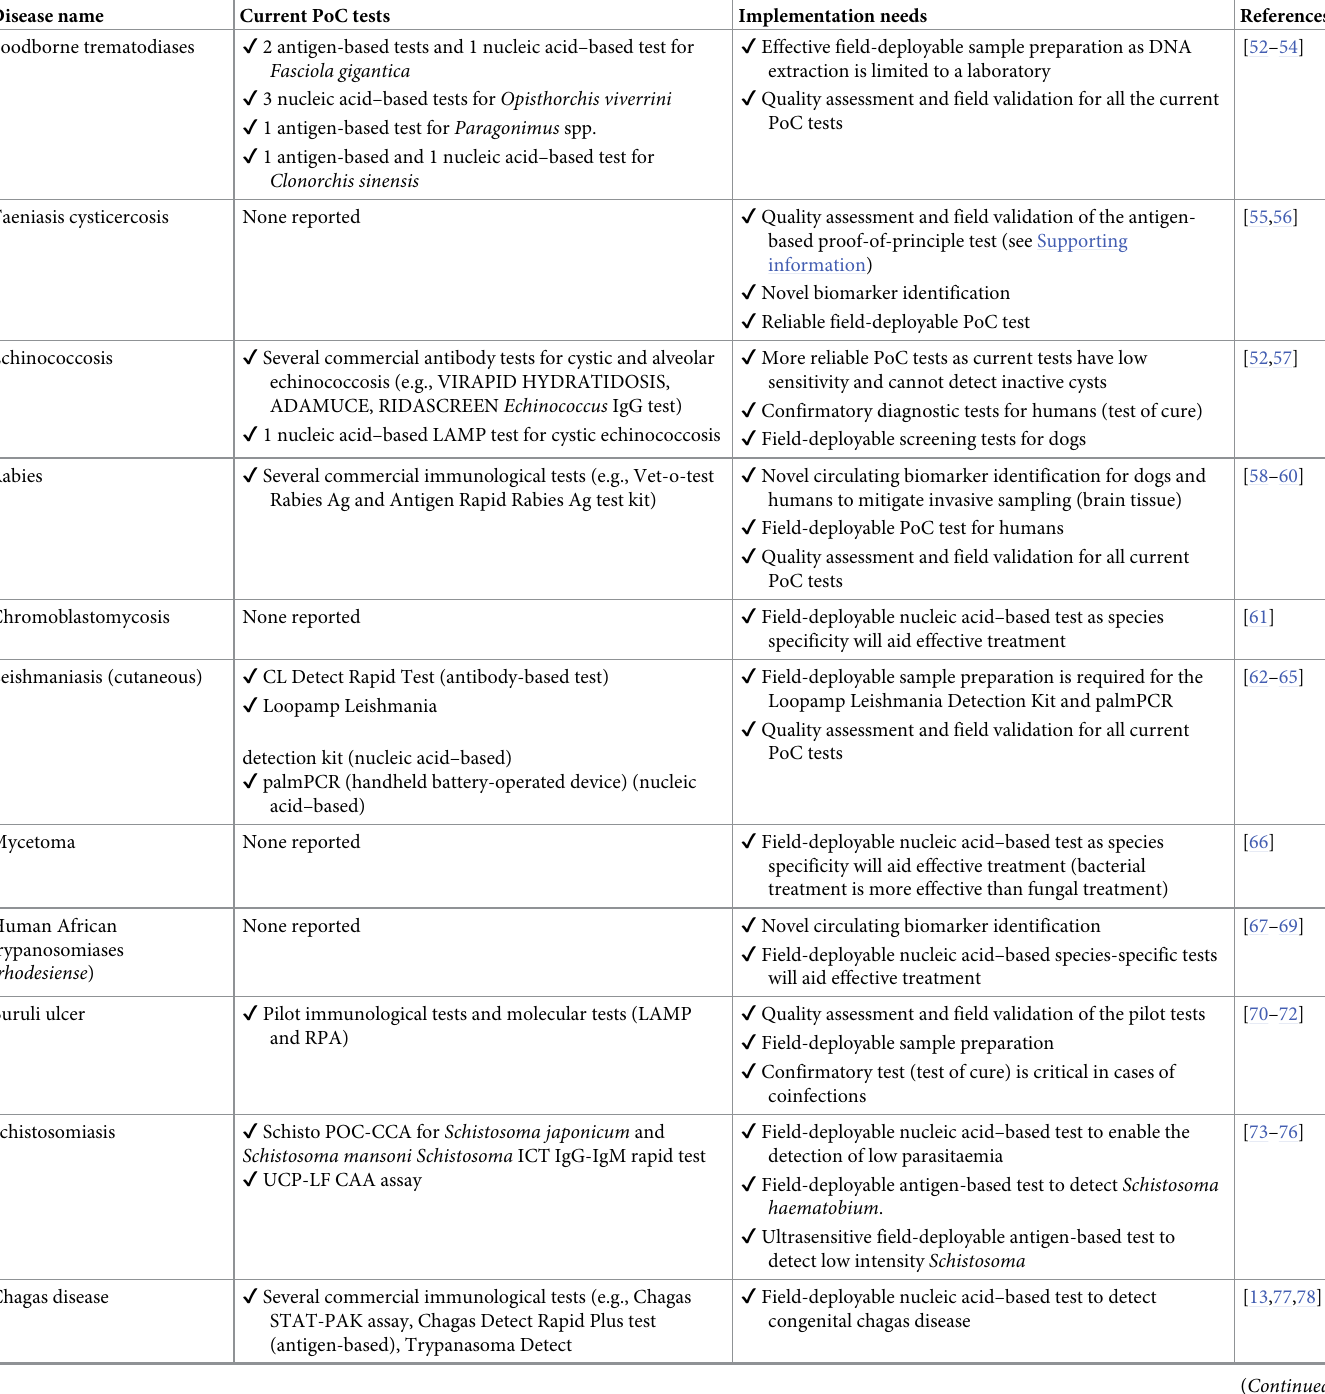
Table 1. NTD-specific status quo of existing PoC test and future implementation needs for PoC tests. Disease